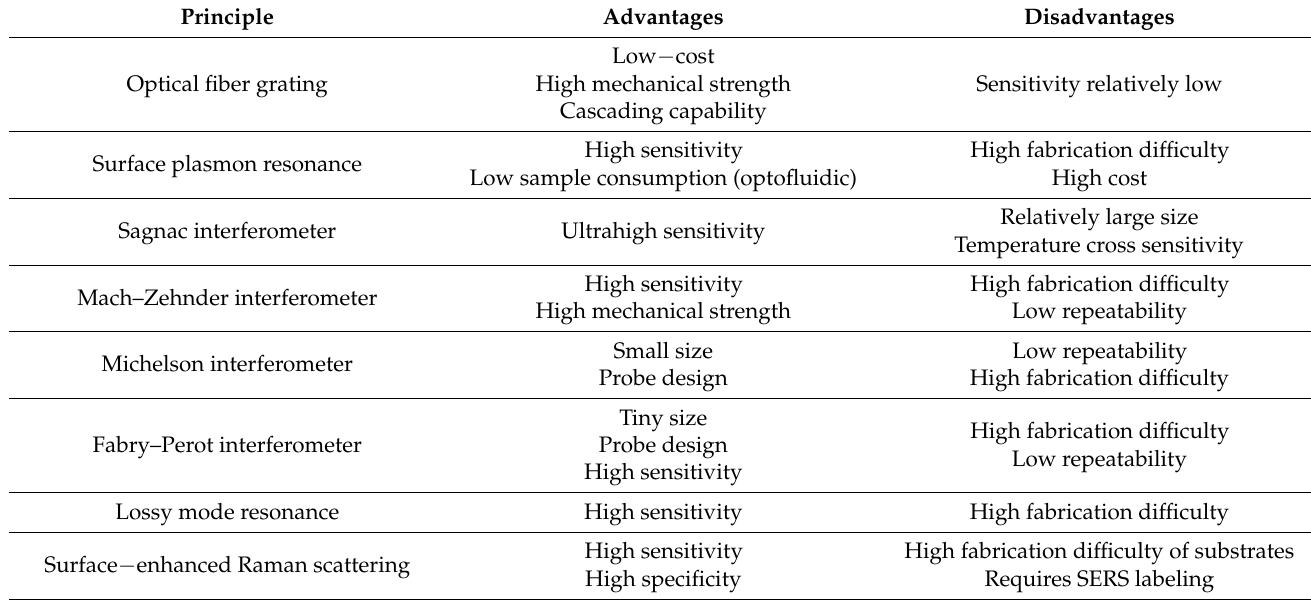
Table 2. Overview of different optical fiber biosensor sensing